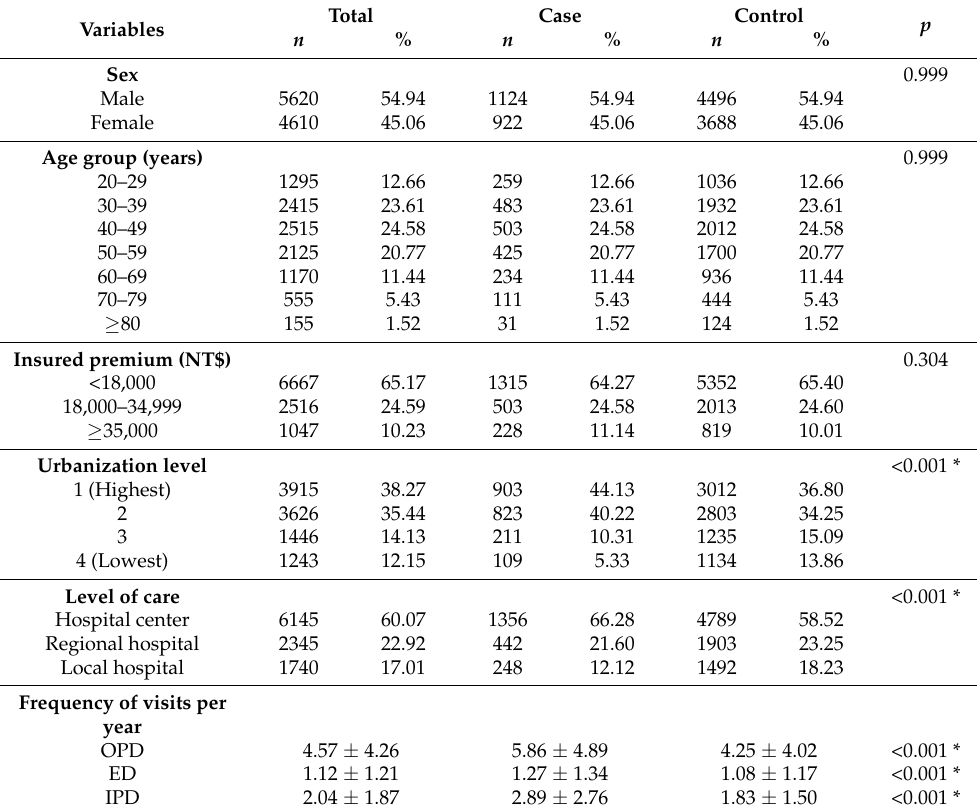
Table 1. Characteristics of case cohort and control